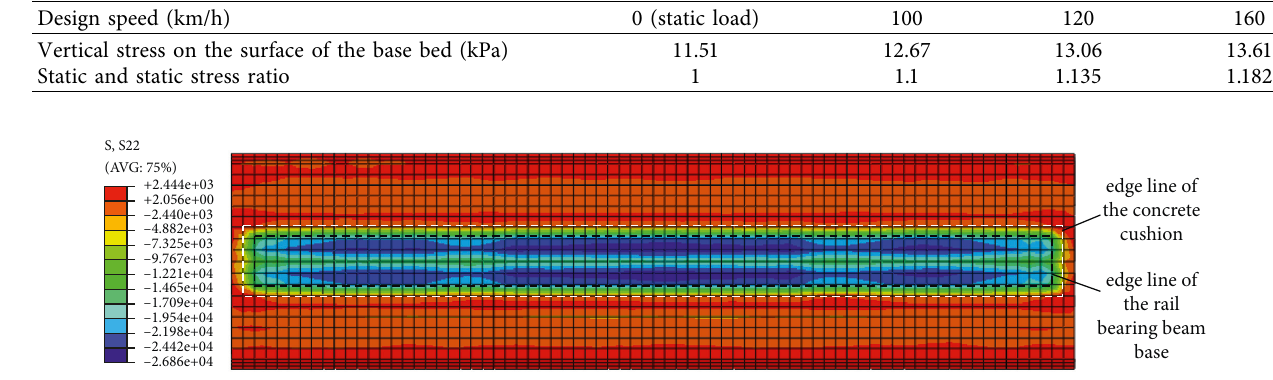
Figure 9: Cloud diagram of vertical stress distribution on the upper surface of the base bed.